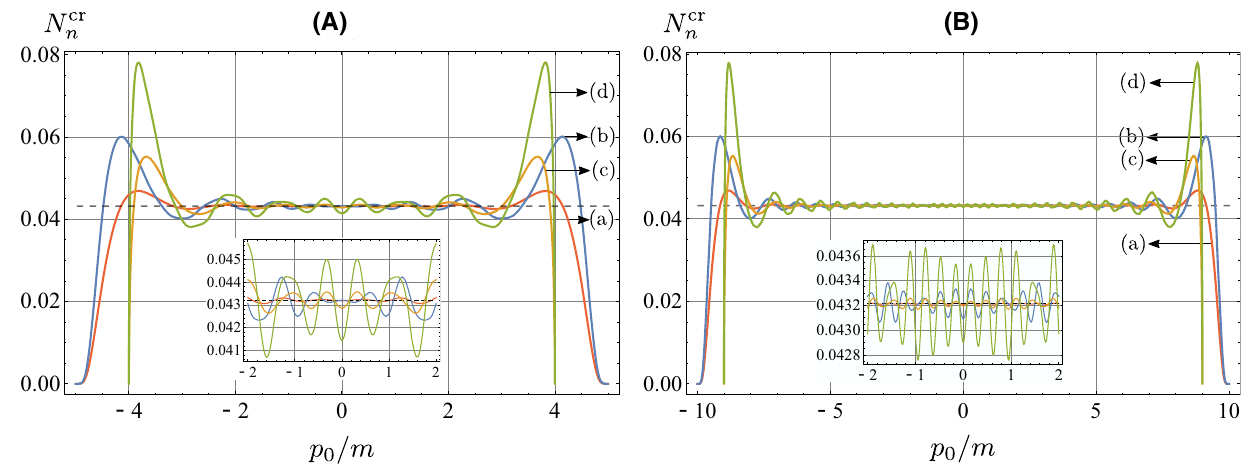
Fig. 8 Differential mean numbers N cr n of particles created from the vacuum by the composite electric field (106) [solid lines (a, b)] and by the L -constant electric field (105) [solid lines (c, d)], with field ampli- tudes E = E c and length scales m ξ 1 = m ξ 2 = 1. In the left panel ( A ), mL = 10, while in the right panel ( B ), mL = 20. The distribu-